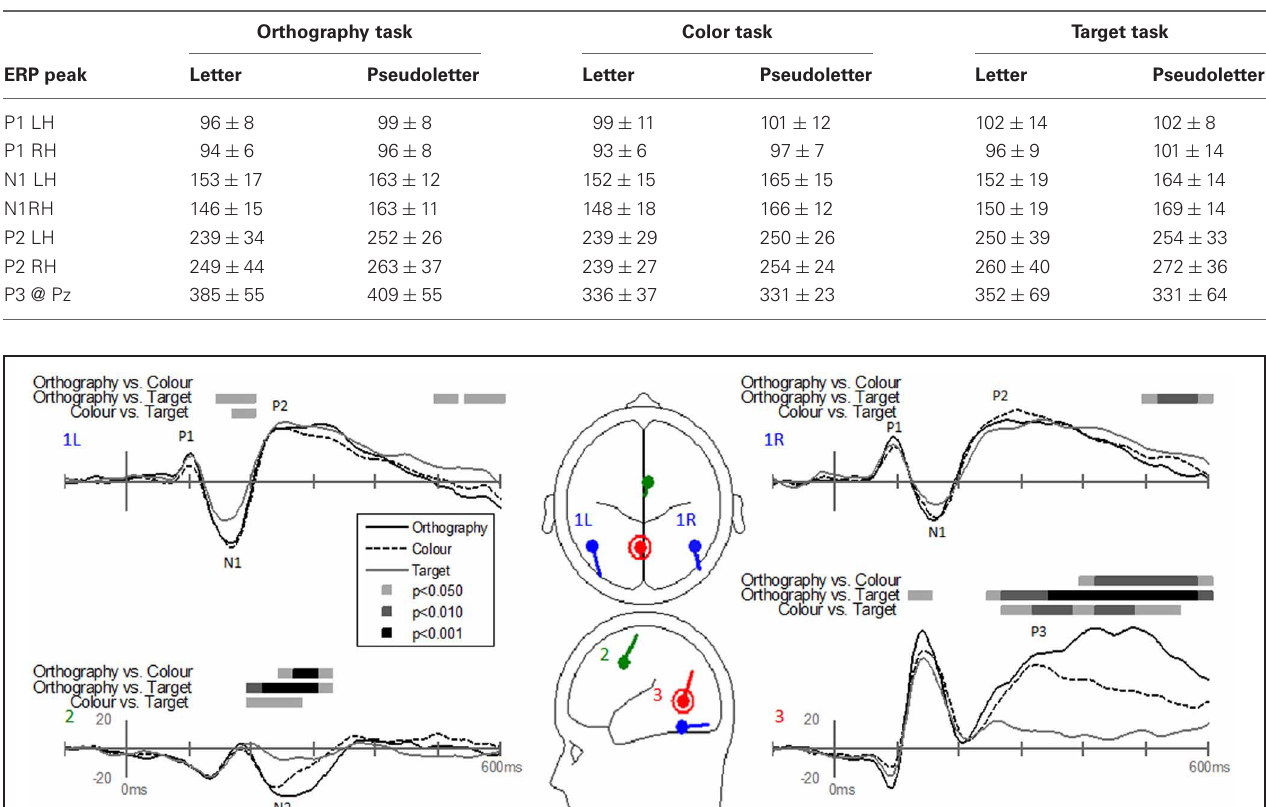
medial lingual gyrus (dipole 3). Bars above the waveforms designate intervals of significant differences between task comparisons at p < 0 . 05, p < 0 . 01, and p < 0 . 001. Vertical axis scale for waveform plots is in